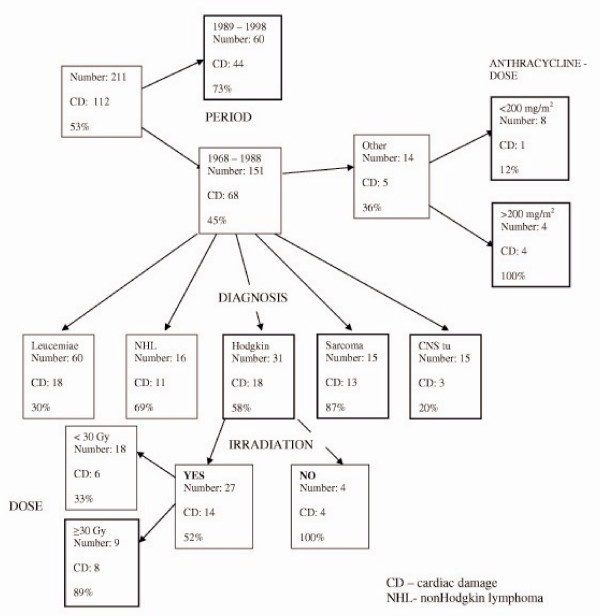
Decision tree for overall cardiac damage after treatment of childhood cancer.